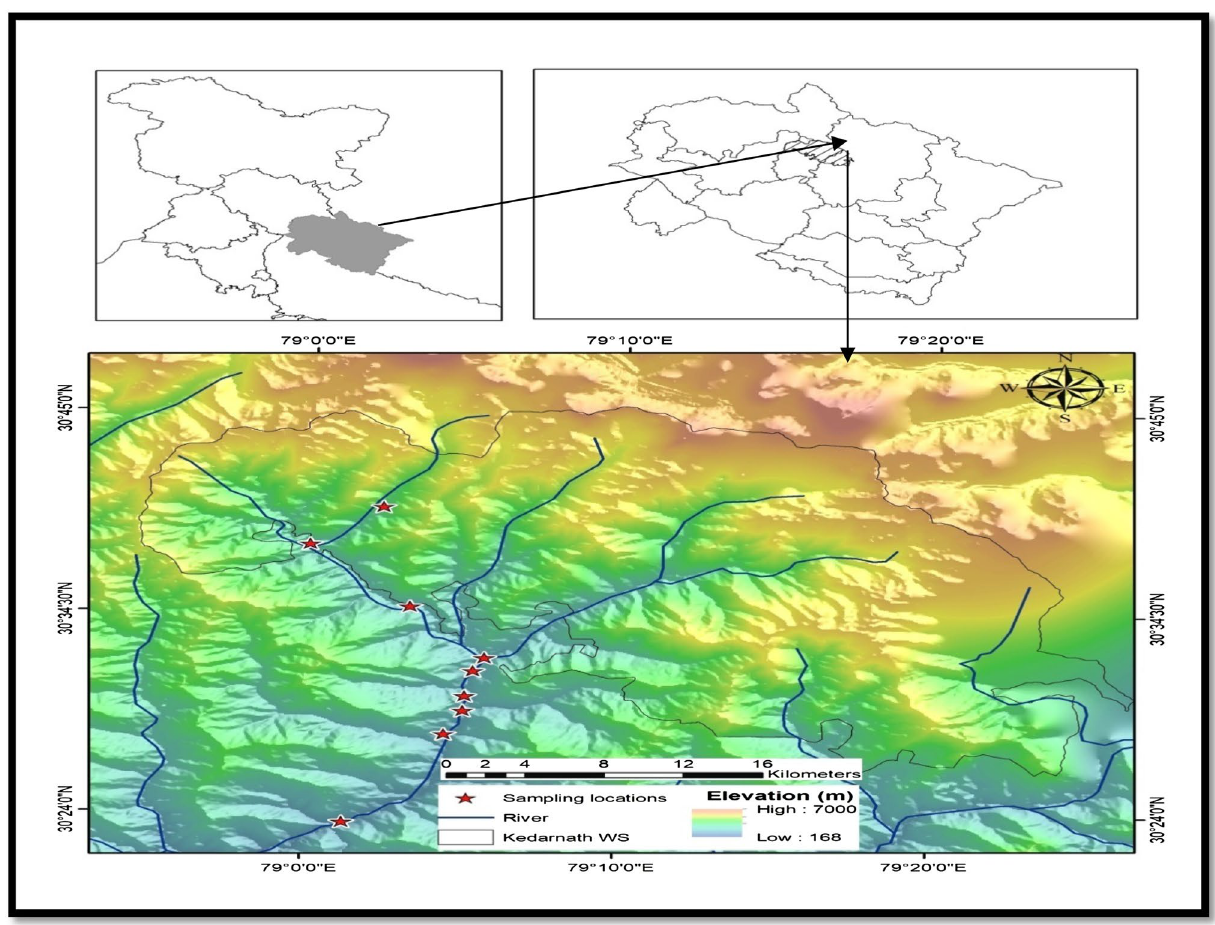
Fig. 1 Map of the sampling sites in Mandakini River, Rudraprayag Uttarakhand,